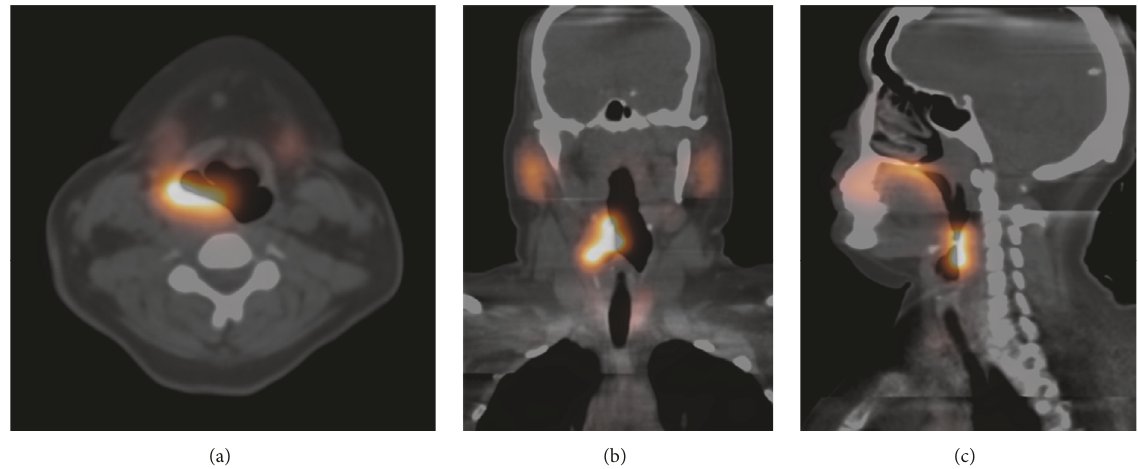
Figure 2: SPECT-CT images from the second 99 m Tc-pertechnetate thyroid scan ((a) axial, (b) coronal, and (c) sagittal) localize the mass to the posterior right